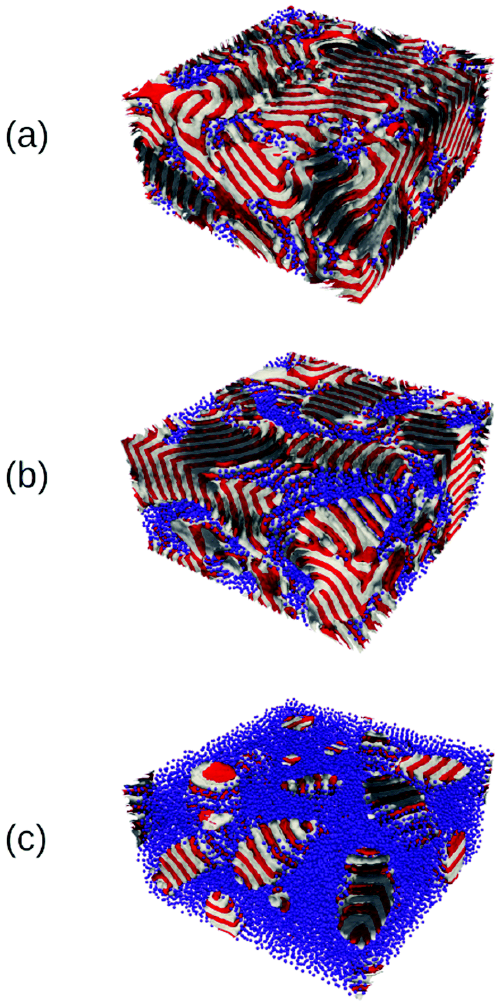
Figure 13. Phase transition of a symmetric ( f 0 = 0.5) BCP induced by the presence of a concentration φ p of neutral NPs. The concentrations of NPs are φ p = 0.1, 0.24 and 0.45 for ( a – c ), respectively. Reprinted with permission from Ref. [182] Copyright 2019 from the Royal Society of